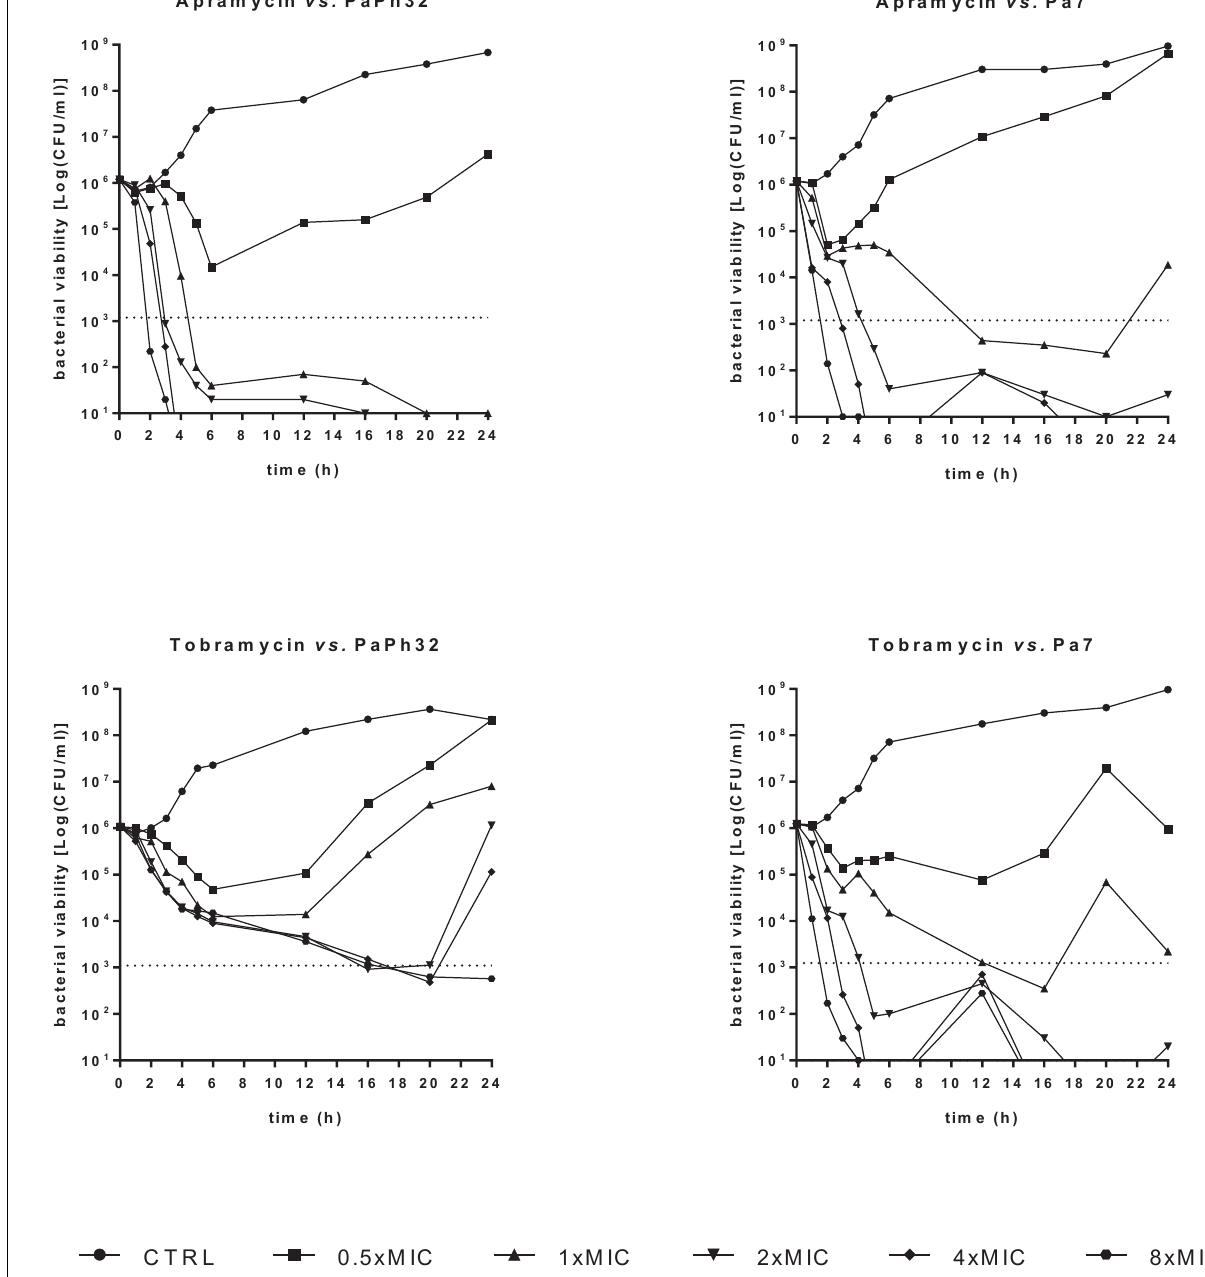
FIGURE 2 | Time-kill kinetics. The kinetics of apramycin and tobramycin activity was carried out over 24 h in liquid medium. P. aeruginosa PaPh32 and Pa7 were selected as representative of tobramycin-resistant and -susceptible strains, respectively. Each antibiotic was tested at MIC value (apramycin: 32 and 64 mg/L, respectively, for PaPh32 and Pa7; tobramycin: 64 and 2 mg/L, respectively, for PaPh32 and Pa7), and its fractions and multiples. The dotted line indicates bactericidal activity, defined as a ≥ 3 Log (CFU/mL) reduction of the initial inoculum size. The limit of detection was 10